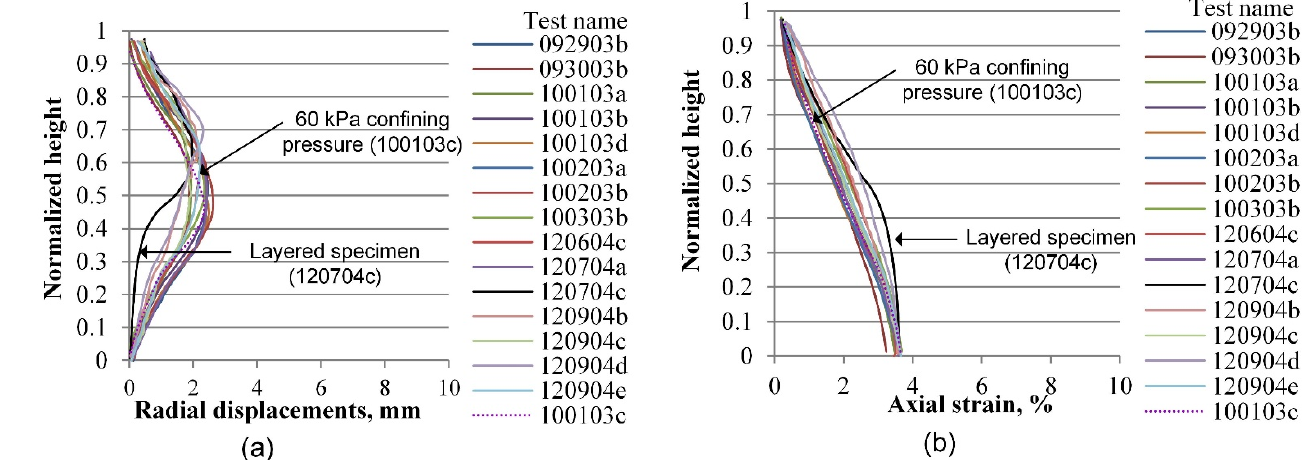
Figure 21. Vertical profile of averaged displacements at 3.6% of the axial strain of sand specimens prepared by the vibratory compaction method: radial displacements field ( a ) and vertical displacements field ( b ).